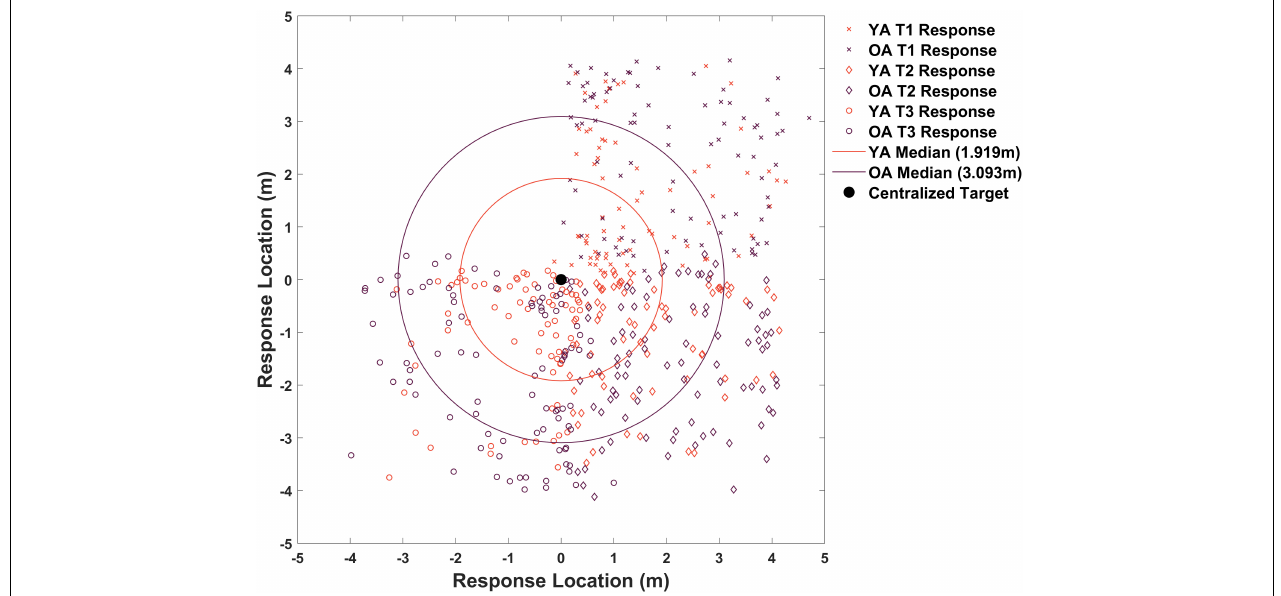
FIGURE 4 | Memory for target locations across all trials. Responses in orange correspond to younger adults and responses in plum correspond to older adults. X’s are all probe responses for target 1, diamonds are all probe responses for target 2, and circles are all probe responses for target 3. All responses are centralized around (0,0) to better show distance from a single centralized target. Older adults remembered the target as further from the actual location than younger adults. Note: the upper left quadrant has few data points because we employed three